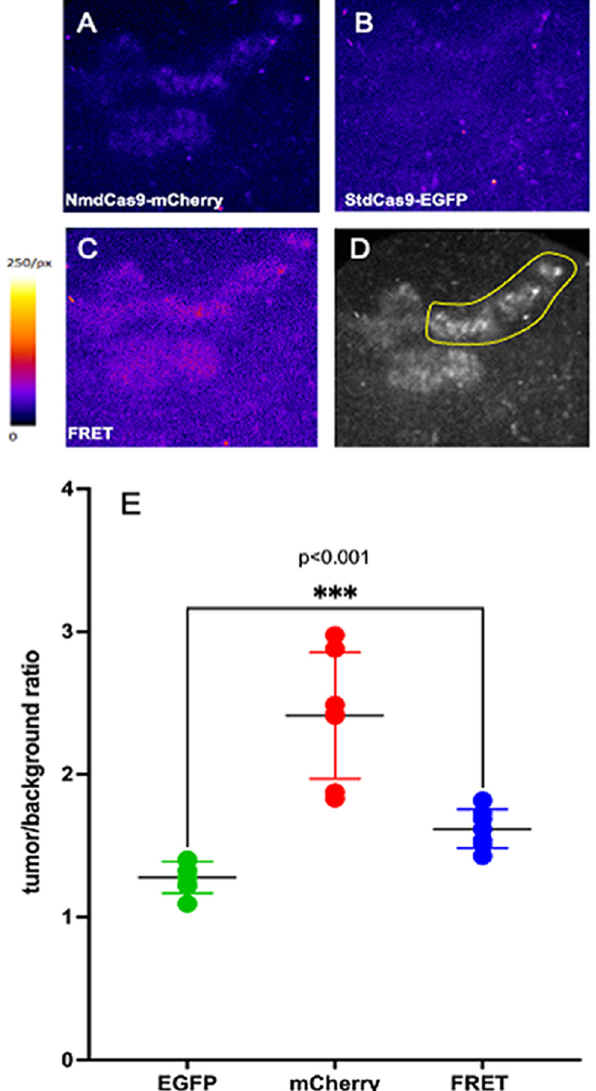
Figure 5. Fluorescence of subcutaneous E9 tumor xenograft ( А 549 Std С as9-EGFP- Nmd С as9- mCherry) on the 3rd day after Dox induction (2 × 200 µg via gavage) and at 15 min application of 70% GB solution. FI images were obtained using a confocal scanner. Excitation wavelengths: 480 nm (donor) and 540 nm (acceptor). ( A ) Fluorescence intensity imaging of NmdCas9-mCherry (AOFT